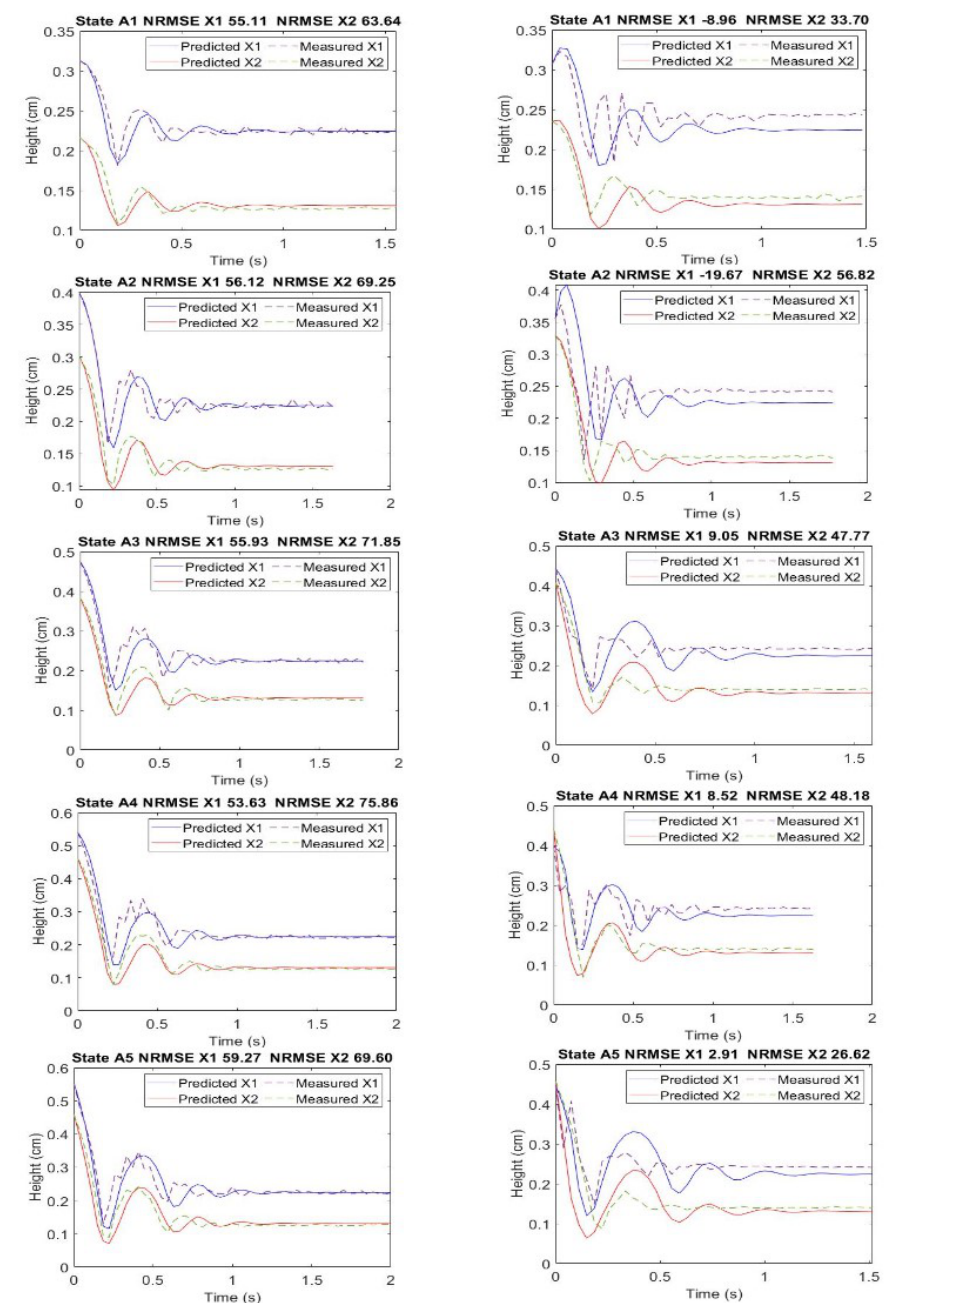
Figure 6. State signals profiles. Left column shows the spring stiffness coefficient without degradation while the right column shows the simulated degradation of the stiffness